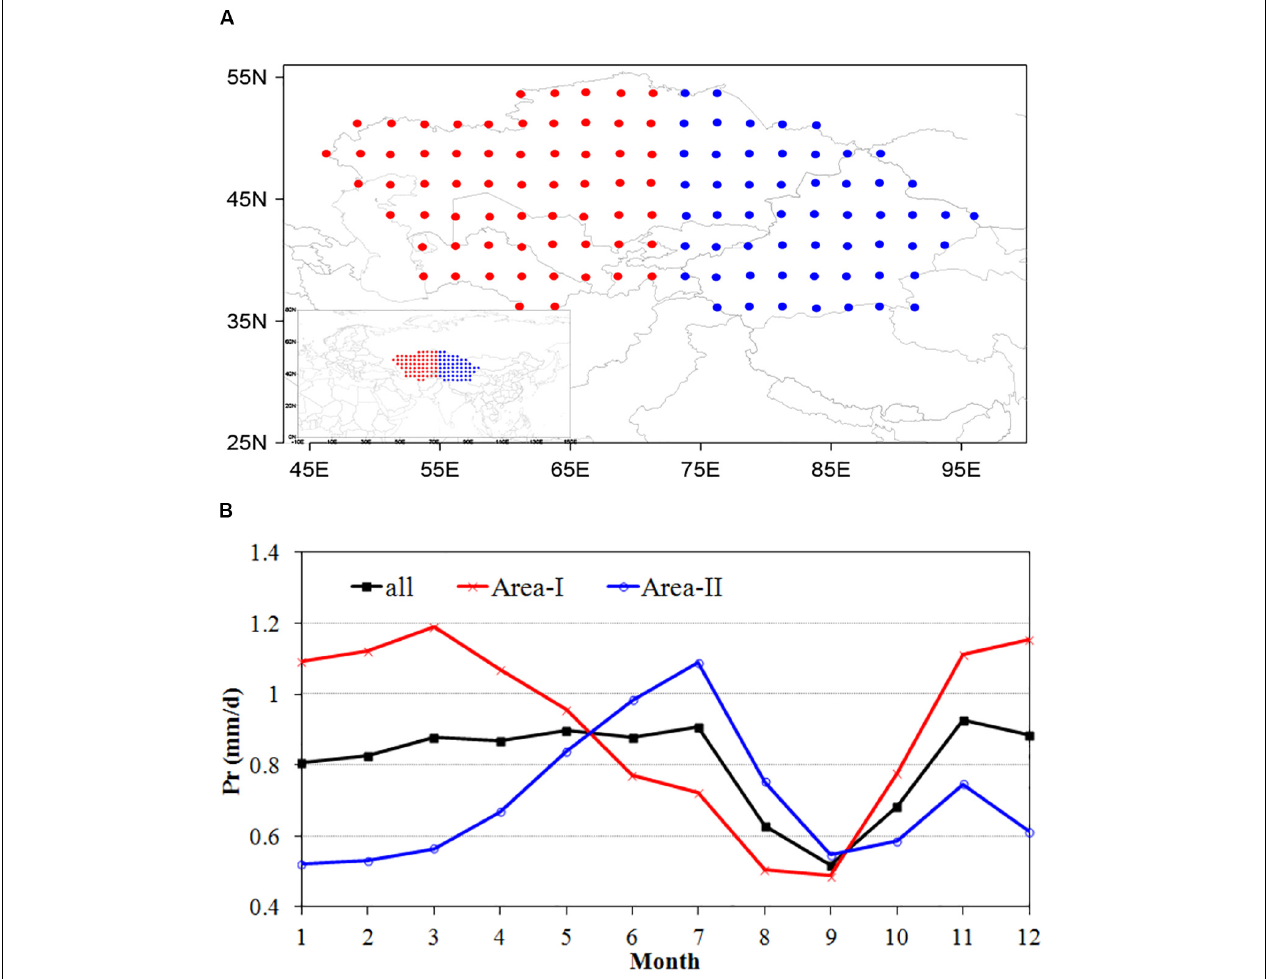
FIGURE 2 | (A) Climatological setting for the two subdivisions (red, region I; blue, region II) of Central Asia and (B) their annual cycles of precipitation (mm day − 1 ). The grid points in part (A) are chosen to match those for the precipitation statistics and the HYSPLIT simulation.